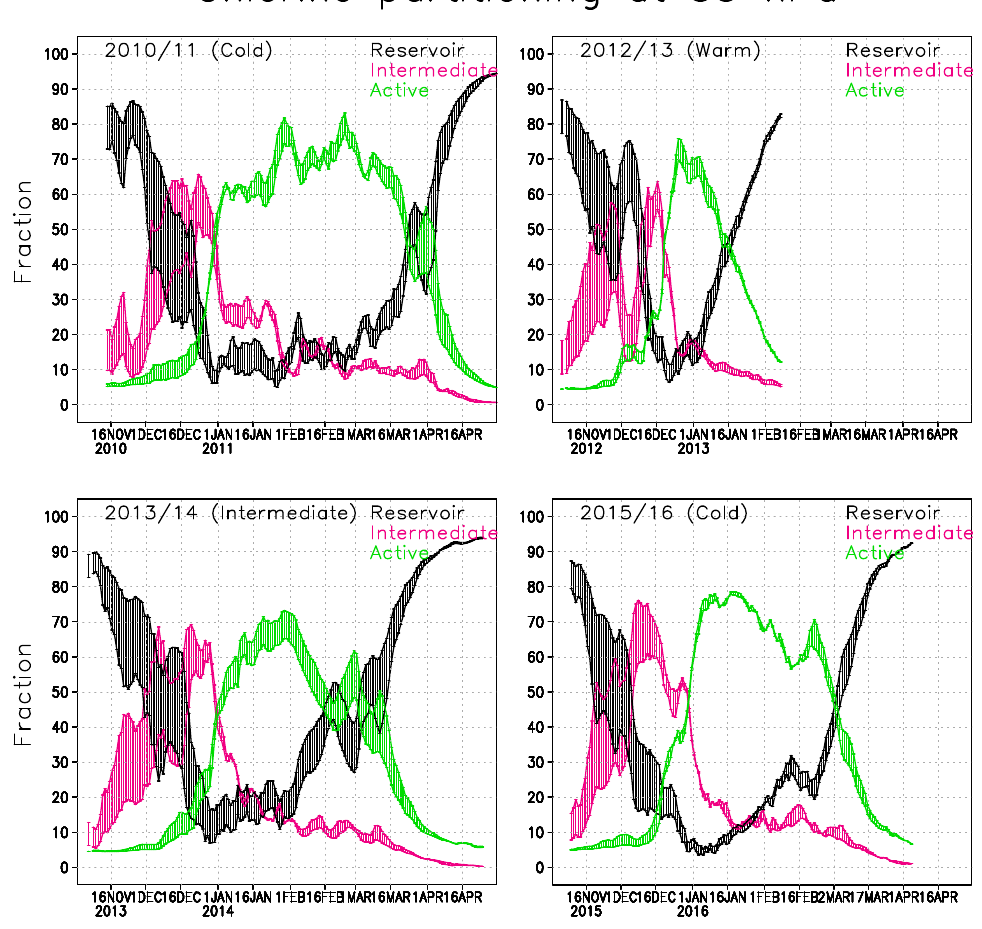
Figure 6. Chlorine partitioning (%) within the Arctic polar vortex at 55hPa in the Min and Max simulations. Active form (green) is Cl + ClO + 2 × Cl 2 O 2 . Intermediate (magenta) contains 2 × Cl 2 + HOCl + OClO + BrCl + ClNO 2 and reservoir chlorine (black) HCl + ClONO 2